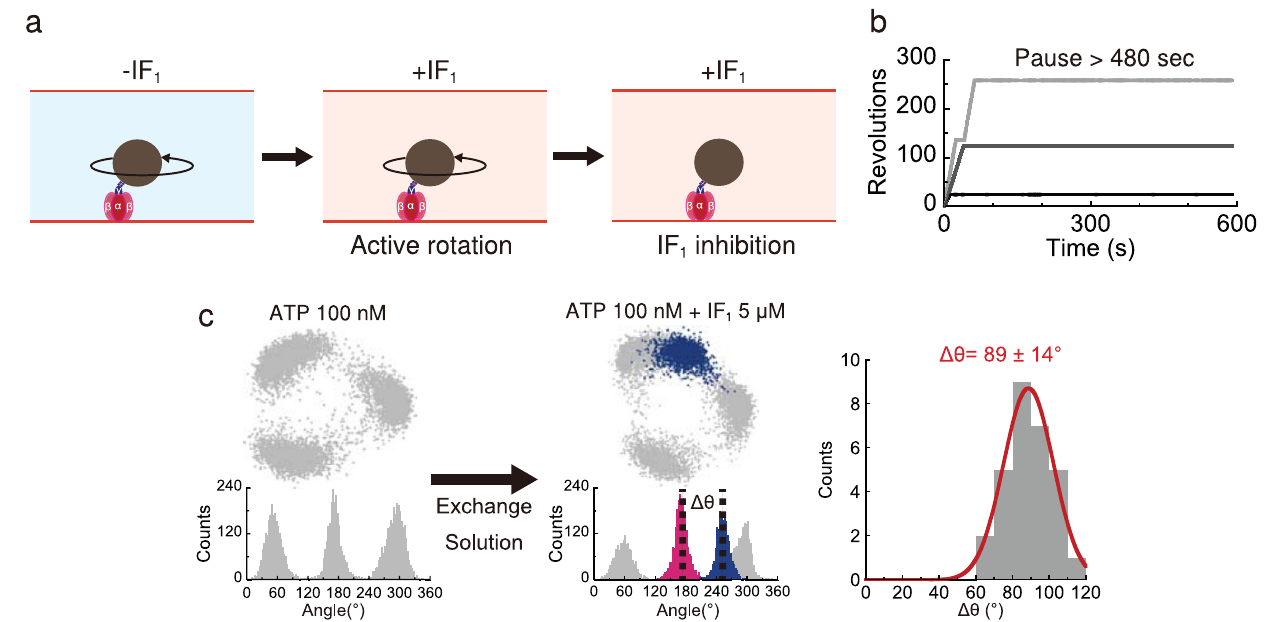
Fig. 2 | Single-molecule analysis of IF 1 -inhibited b MF 1 . a Experimental method. After observing a rotating b MF 1 molecule in IF 1 -free solution, we introduced a mixed solution with IF 1 into the reaction chamber. The b MF 1 continued to rotate for a while but fi nally stopped rotation. b Typical time courses of b MF 1 in the presence of 3 μ M IF 1 and 1mM ATP. See Supplementary Fig. 2 for more detailed analyses. Source data are provided in the Source Data fi le. c Stall positions of IF 1